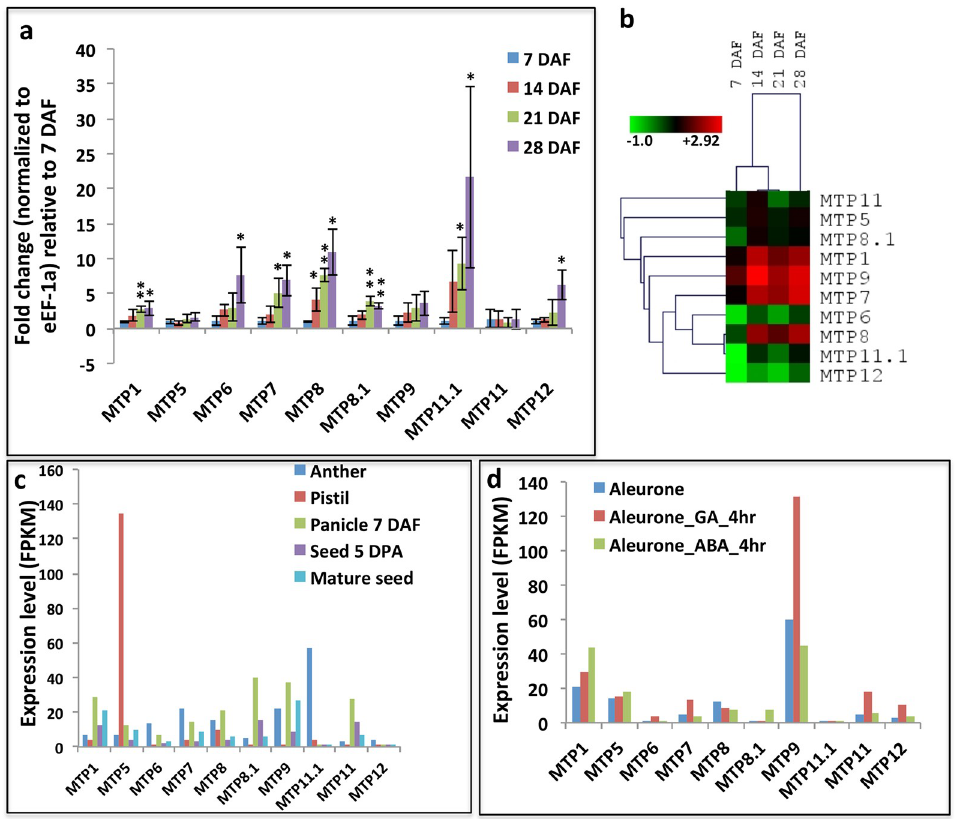
Fig 4. Expression profile of rice MTP genes during reproductive growth. ( a ) Q-PCR analysis showing normalized expression of MTP genes in developing seeds at different DAF (Days After Fertilization) stages. Fold change between different time points is calculated against 7 DAF stage. Asterisks indicate T-test results where � = p < 0.05, �� = p < 0.01, ��� = p < 0.001. ( b ) Hierarchical clustering of Q-PCR results showing the expression profile of MTP genes in developing seeds. Relative fold change of MTP expression (normalized against OsUBQ5 ) was calculated against OseEF-1a expression (normalized against OsUBQ5 ) gene. The resuting fold change values were then used to make heatmap. The heatmap representing hierarchical clustering of log2 transformed expression values of MTP genes at different developmental stages (indicated at the top of each lane) was generated using MeV software package (http://mev.tm4.org/ ). The color bar below represents relative expression value from green color representing the lowest expression levels, black represents medium expression levels, and red signifies the highest expression level. ( c, d ) Expression values of rice MTP genes at various stages of reproductive growth shown as FPKM (fragments per kilobases of gene per million mapped reads) values obtained from Rice Expression Database (http://expression.ic4r.org/). ( d ) Expression in aleurone layer and effect of GA (Gibberellic Acid) and ABA (Abscisic Acid) on aleuronic expression.